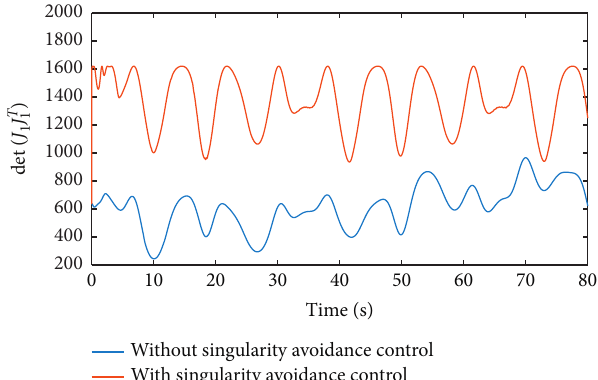
Figure 9: Manipulability of robot 1 with (a) and without (b) singularity avoidance